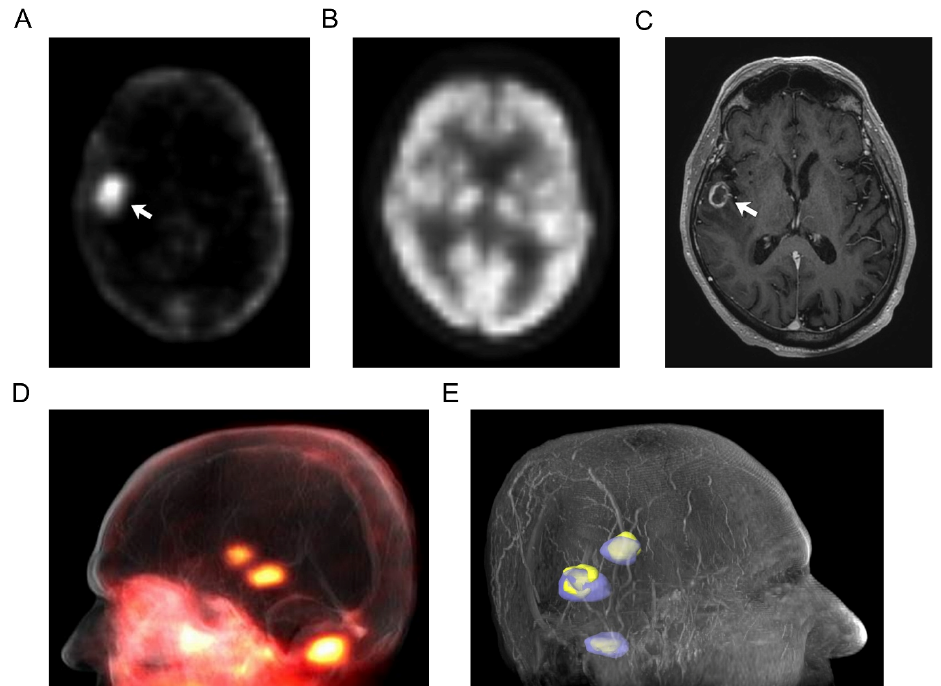
Figure 1. Unsuspected brain metastases in 70-year-old man with primary bronchogenic carcinoma. Transverse PET image ( A ) obtained 6 days after injection of 185 MBq [ 124 I]I-NM404 shows a right hemispheric focus of activity (arrow) that was not detectable on [ 18 F]FDG PET ( B ) but confirmed on subsequent contrast-enhanced MR (( C ), arrow). Fused volume-rendered [ 124 I]I-NM404 PET-MR im- age ( D ) shows a total of three unsuspected brain metastases (2 cerebral and 1 cerebellar) that were identified on [ 124 I]I-NM404 PET and confirmed on MR, which altered the treatment strategy for this patient. Additional fused volume-rendered [ 124 I]I-NM404 PET-MR image ( E ) with segmentation of the brain metastases shows the regions of [ 124 I]I-NM404 uptake (purple), which exceed the regions of abnormal MR contrast enhancement (yellow). The clinical significance of this uptake-enhance- ment discordance within the tumor is uncertain. In another case, increased [ 124 I]I-NM404 uptake matched with a small focus of abnor- mal enhancement in the right frontal lobe on MR in a patient who previously underwent resection and subsequent stereotactic radiosurgery for metastatic melanoma (Figure 2).